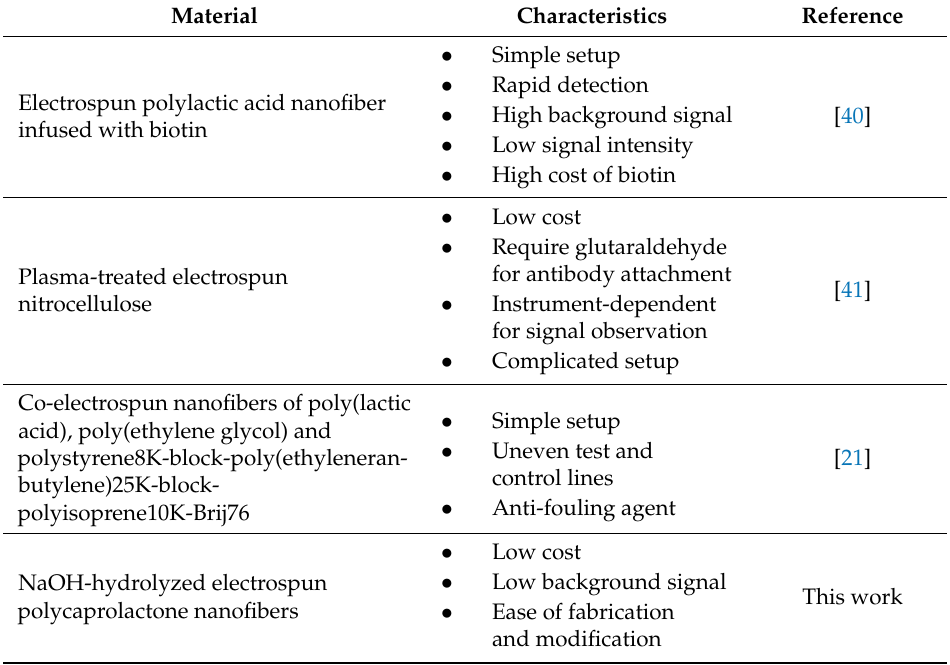
Table 1. Characteristics of the current hydrolyzed electrospun PCL nanofibers and existing electrospun materials in lateral flow sensing